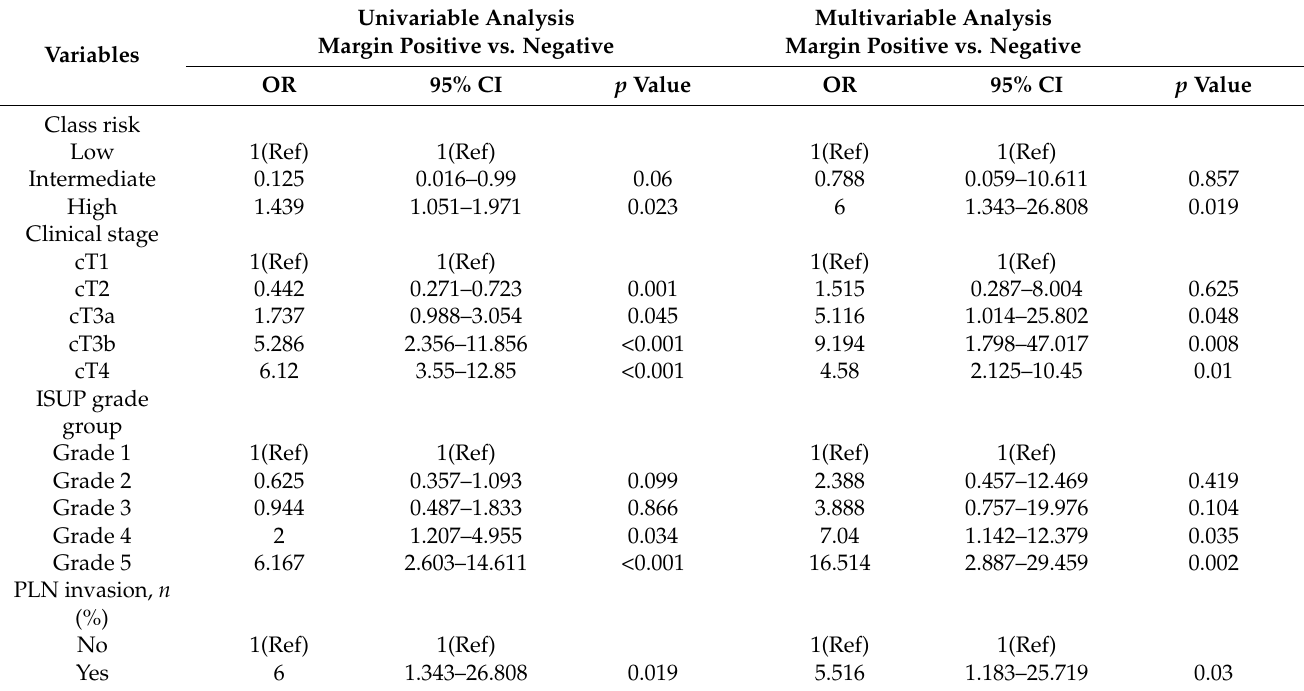
Table 2. Clinical and pathological factors associated with risk of positive surgical margins by the binary logistic regression